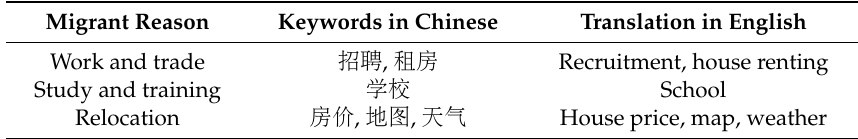
Table 1. Selection of the search keywords. Keywords in